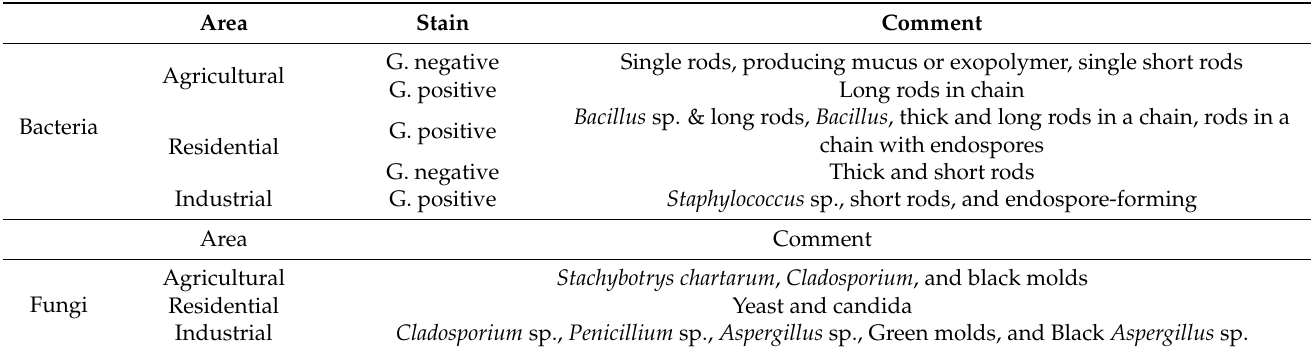
Table 6. Biological characterization of various microbes in AC filters from different sampling